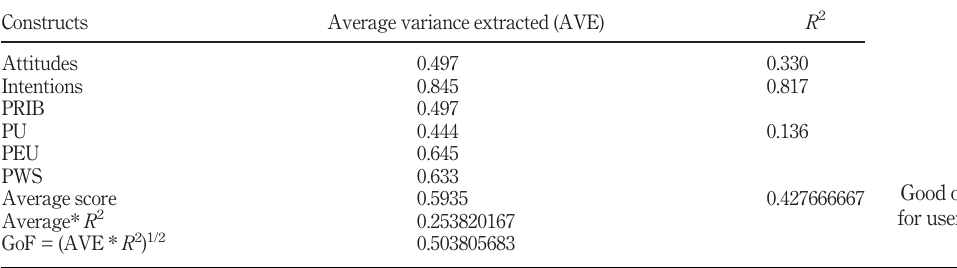
Table 12. Good of fi tness test